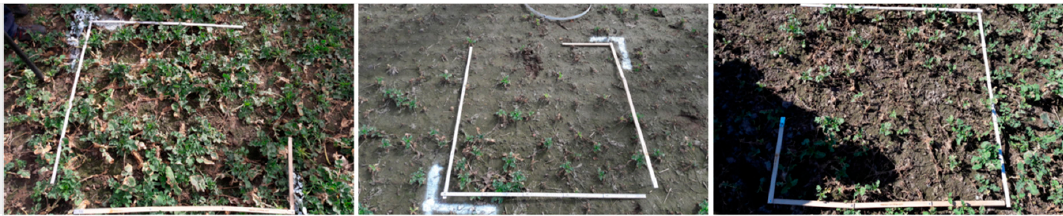
Figure 3. Examples of the training fields (1 m × 1 m).